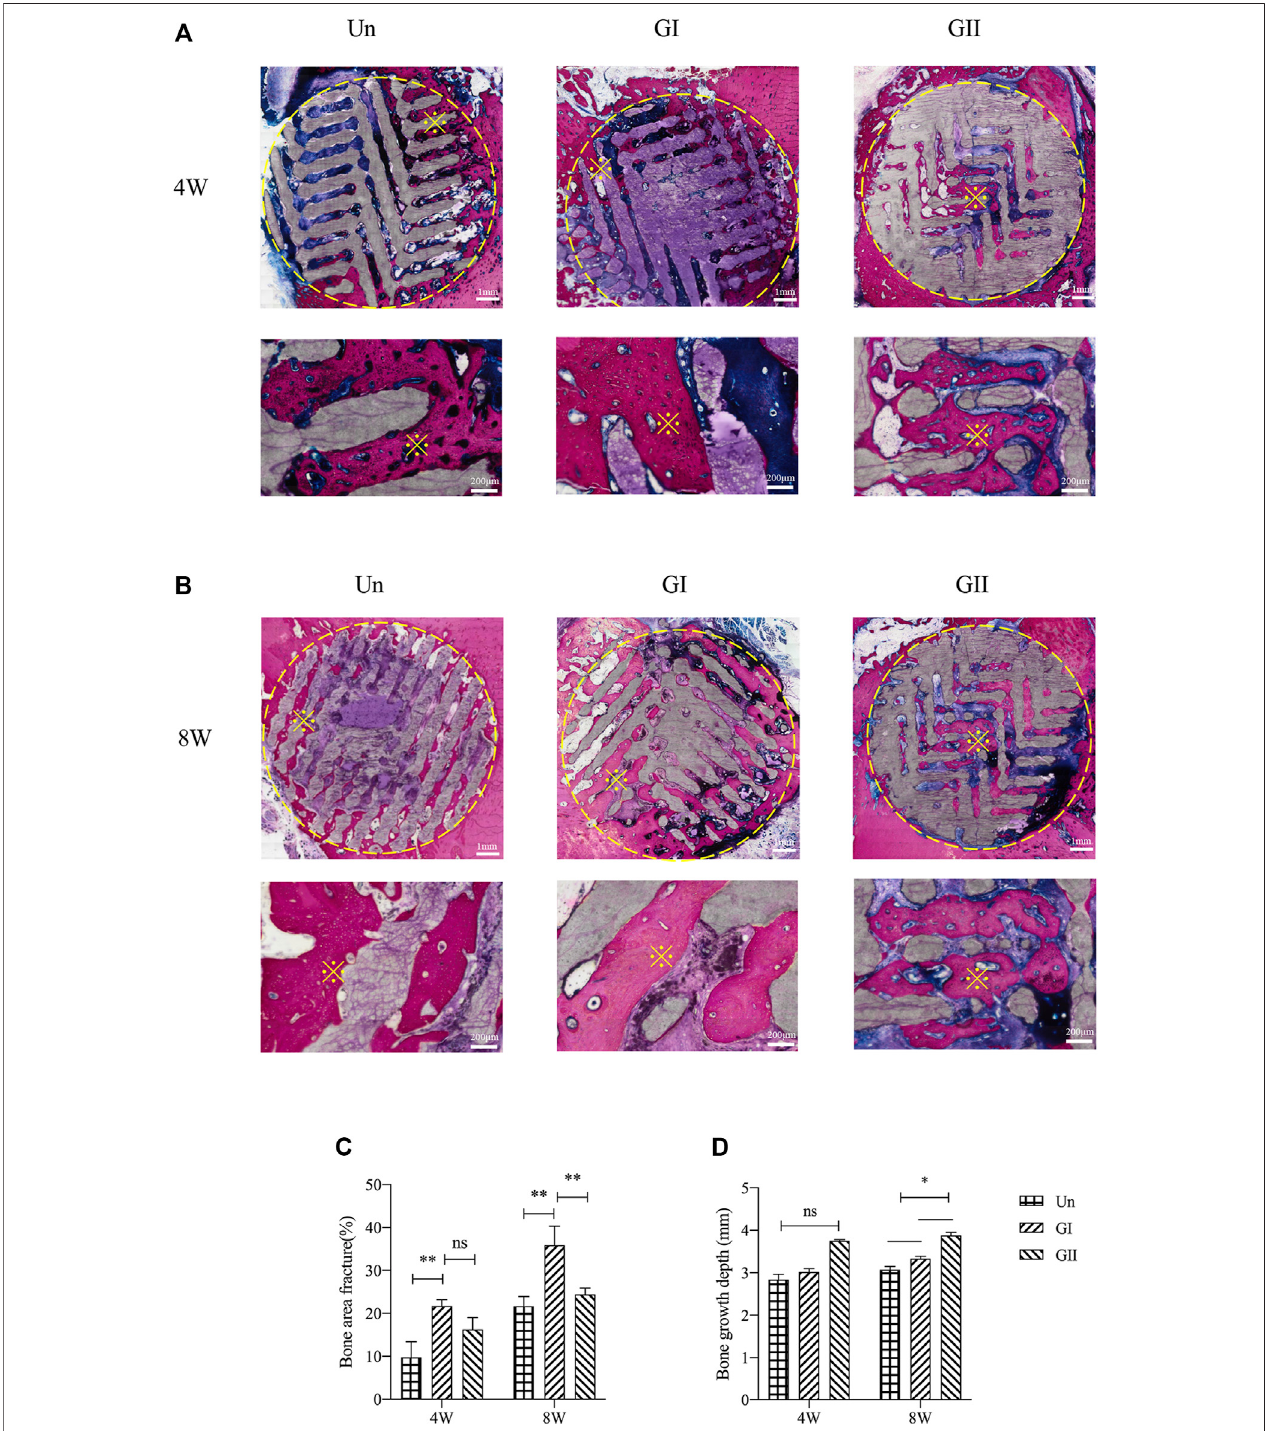
FIGURE 9 | Histological analysis of porous scaffolds implanted into rabbits after 4 weeks (A) and 8 weeks (B) , below is a partial enlargement of the fi gure above, ※ with yellow represents locally magni fi ed point. Bone area fraction (C) and bone growth depth from the outer of the scaffold into the center (D) .